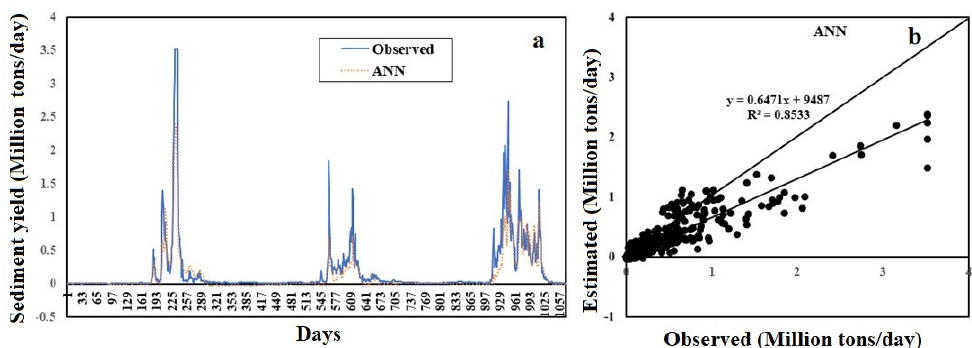
Figure 7. ( a ) Hydrograph and ( b ) scatter plot based on test data between the ANN predicted SSY and observed SSY.